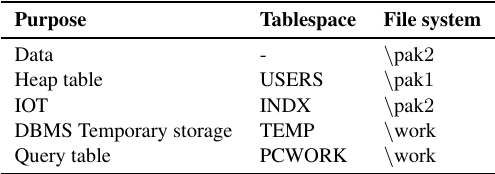
Table 1: The distribution of files and tables in the available disks according to the specific